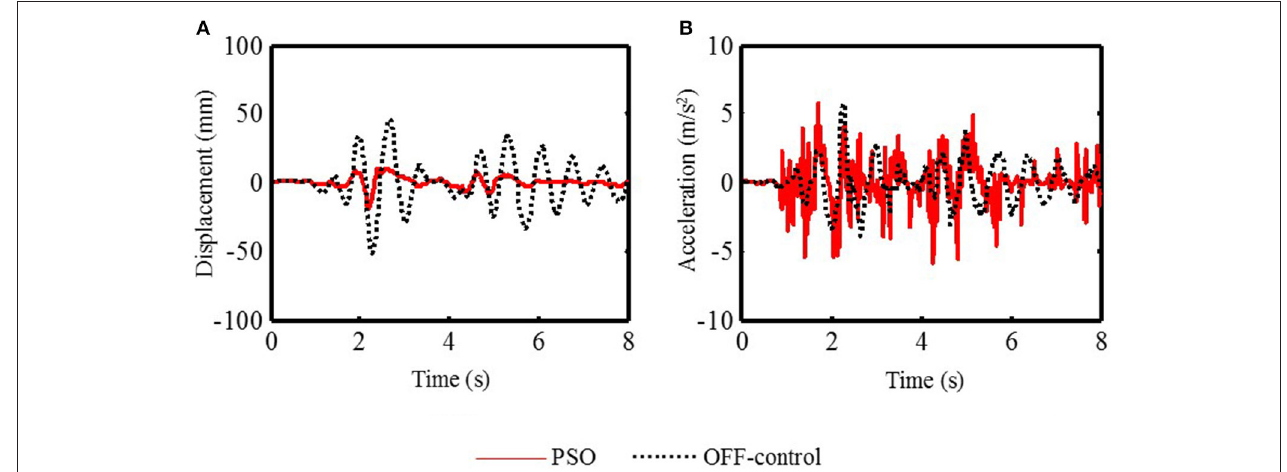
FIGURE 6 | The structural 5th floor response of the PSO control and the OFF-control structure (El-Centrol). (A) The displacement response. (B) The acceleration response.